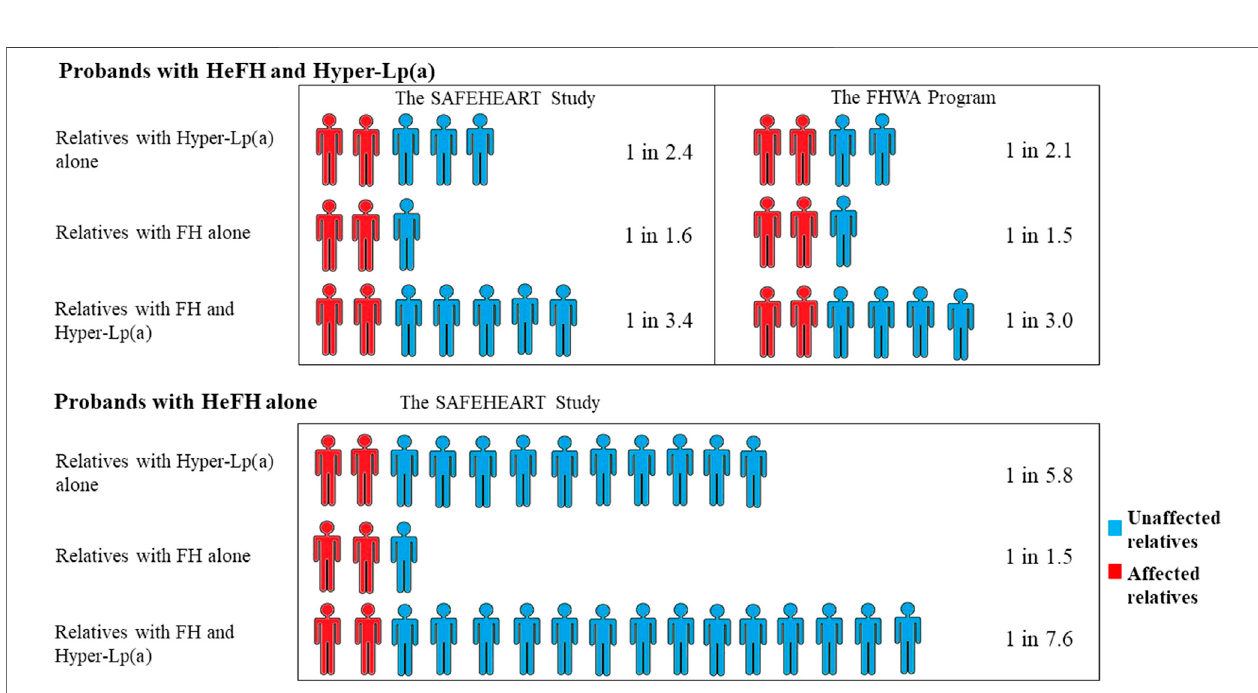
FIGURE5| Yieldofdetectionofdiagnosesofelevatedlipoprotein(a)[Lp(a)]andfamilialhypercholesterolemia(FH)duringcascadescreeningofrelativesfromHeFH probands with or without hyper-Lp(a). One individual of hyper-Lp(a) without FH was detected for every 2.1 – 2.4 relatives screened if the proband had HeFH and hyper- Lp(a), whereasthe yieldofdetection wasoneindividual forevery5.8 relatives screened ifthe proband had HeFHbut nothyper-Lp(a).HyperLp(a) referstoLp(a) ≥ 50 mg/ dL. The SAFEHEART Study by Ellis et al., (2019); The FHWA Program by Chakraborty et al., (2021).